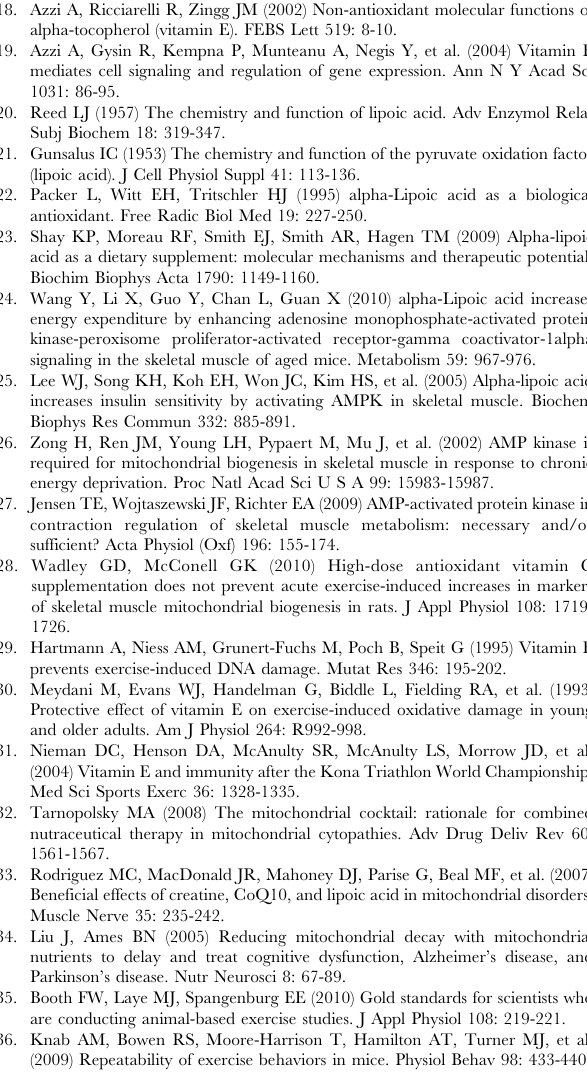
Table S1 Primer Sequences. Primer sequences used in RT-PCR analyses of the expression of specific